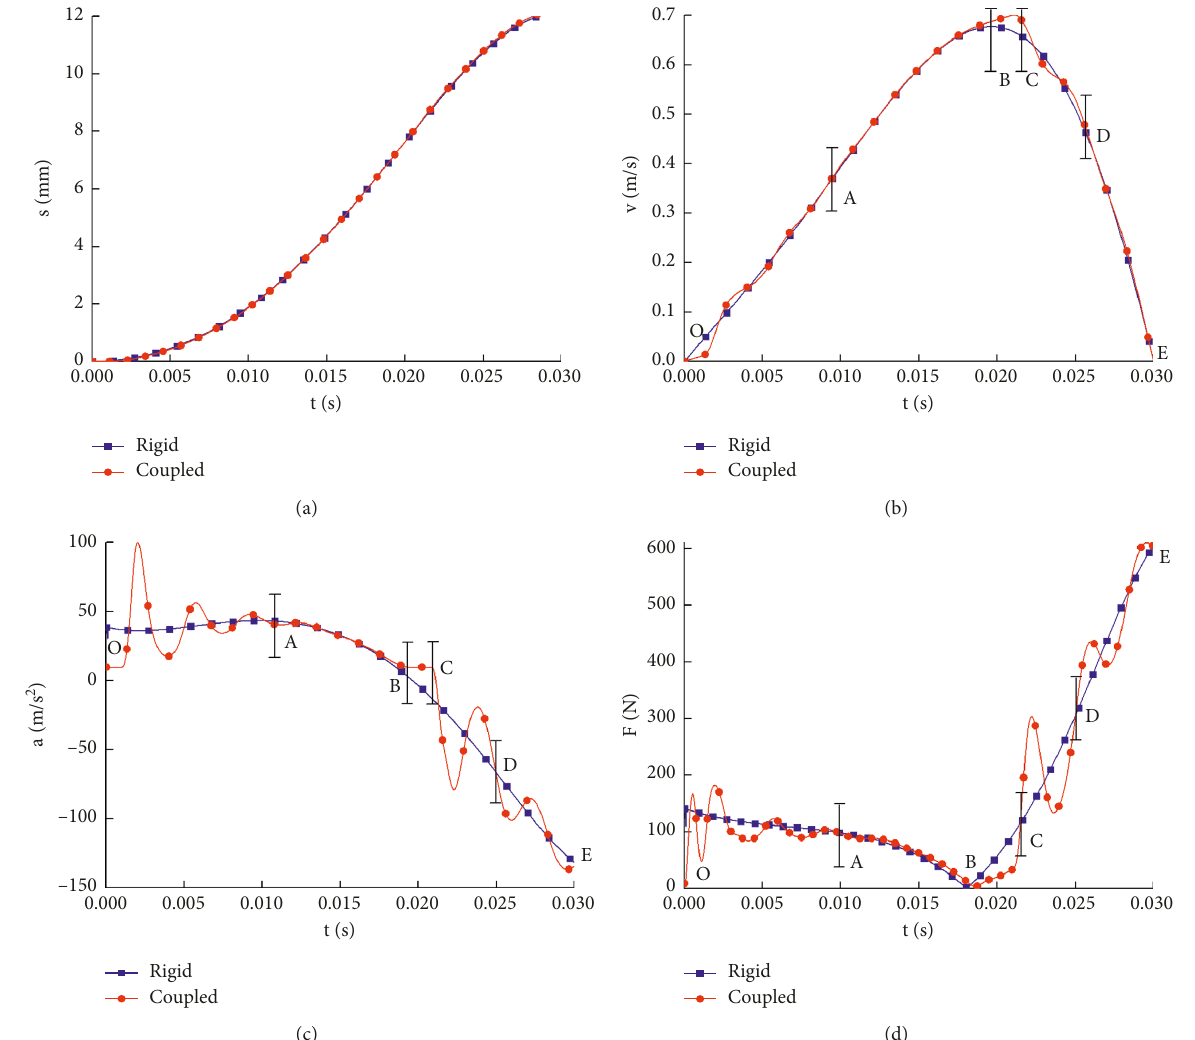
Figure 6: The simulation results of the rigid model and coupled model. (a) Displacement. (b) Velocity. (c) Acceleration. (d) Reaction